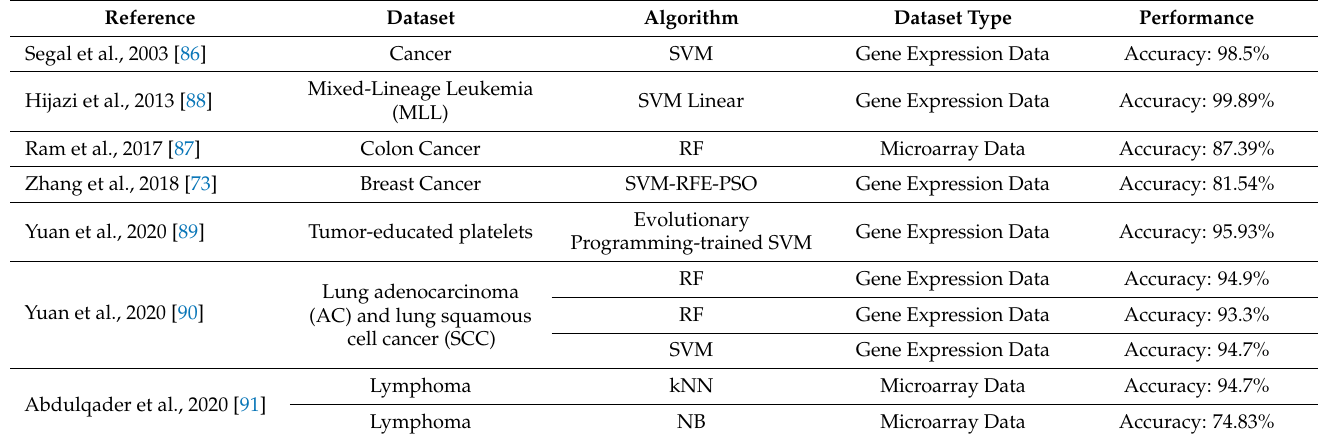
Table 6. Traditional ML-based methods for gene expression